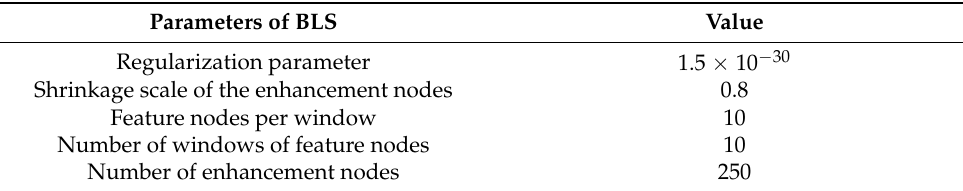
Table 1. Parameters of the broad learning